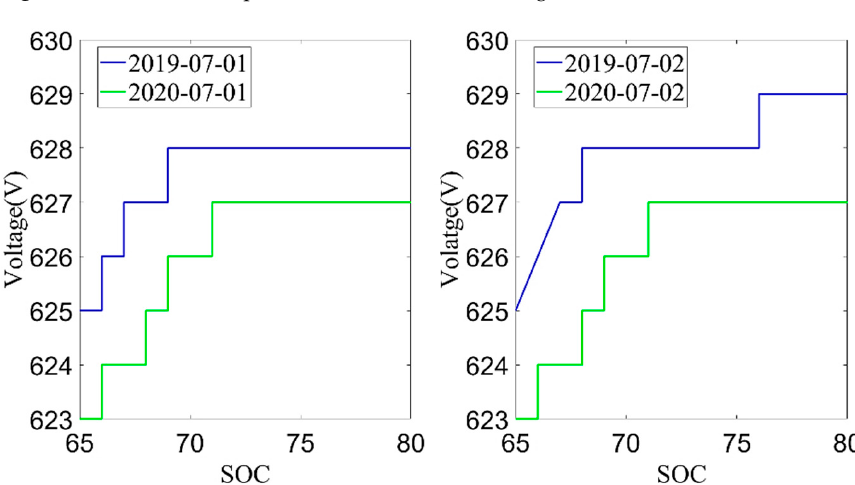
Figure 9. The relationship between SOC and pack voltage.